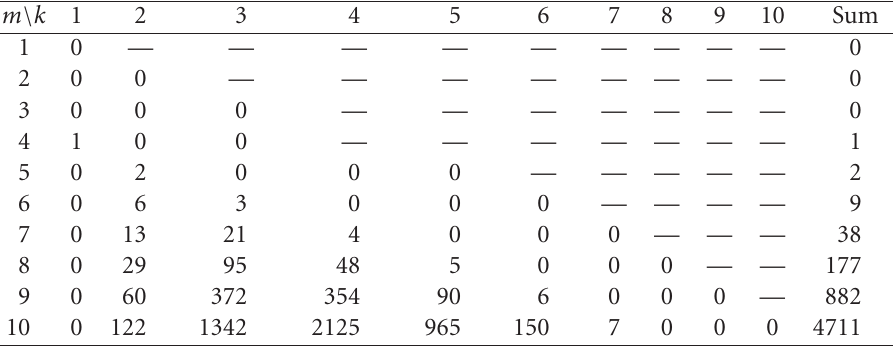
Table 4.2. Partitions of [ m ] with two three-successions c 3 ( m , k ,2)